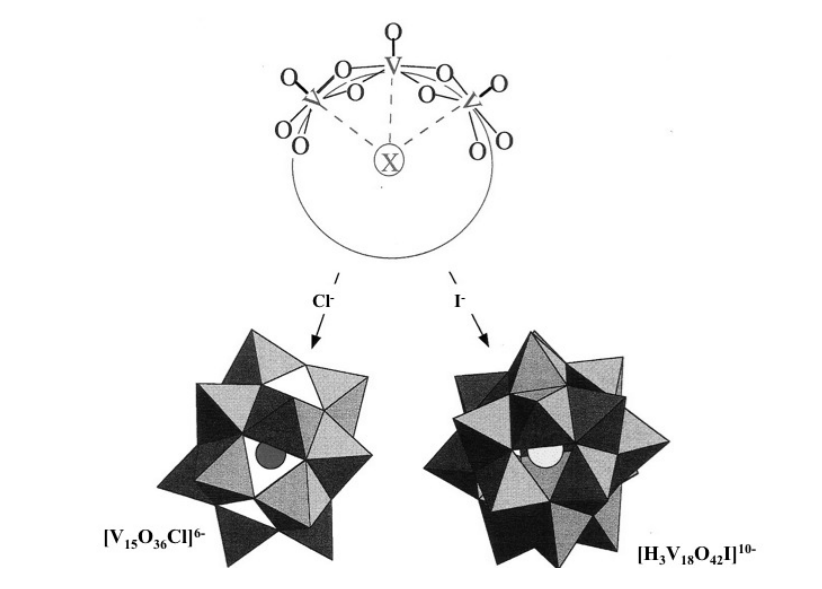
O Cl] 6- and [H 15 36